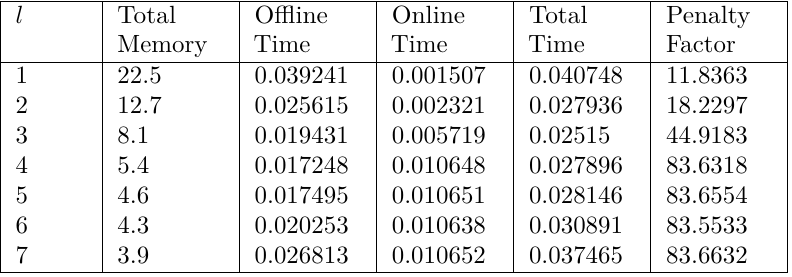
Table 5: Second-order masked S-box compression using the table-based scheme with pre-processing (see Algorithm 6). Total memory required for AES-128 in KB and execution times are in seconds.